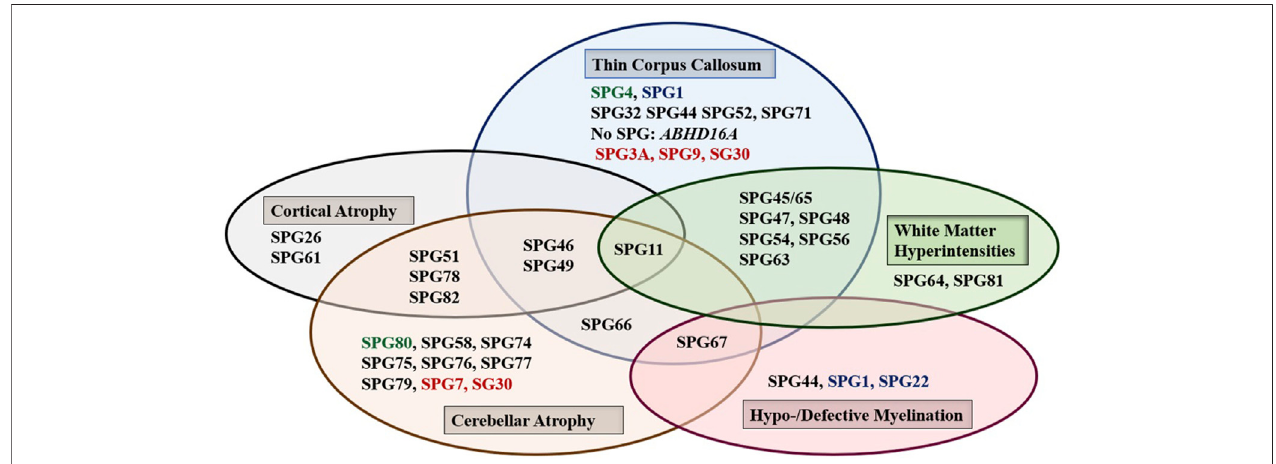
FIGURE 1 | The main abnormal fi ndings in MRI of the brain in different HSP subtypes. Font color codes correspond to various patterns of inheritance: AD HSP (green), AR HSP (violet), X-linked recessive (Blue), and Mixed AR/AD inheritance (red).